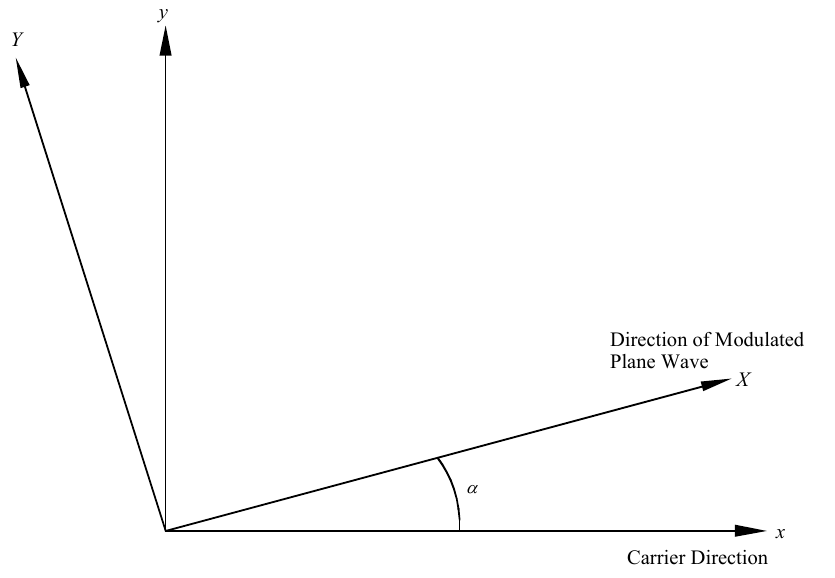
Figure 6. The wavenumber domain for the 2 + 1 NLS equation ( k , l ) = ( k x , k y ) is relative to the origin ( k , l ) = ( k x , k y ) = ( 0,0 ) . The wave spectrum is indicated by the contours: Note that the peak of the spectrum lies at ( k , l ) = ( k x , k y ) = ( k p ,0 ) and the dominant direction lies along k x = 0. The modulational wavenumbers ( K x , K y ) = ( k x − k p , k y ) are centered about the peak of the spectrum. Each radial line in the spectrum is shown in the text to represent a solution of the “rotated” 1 + 1 NLS equation.